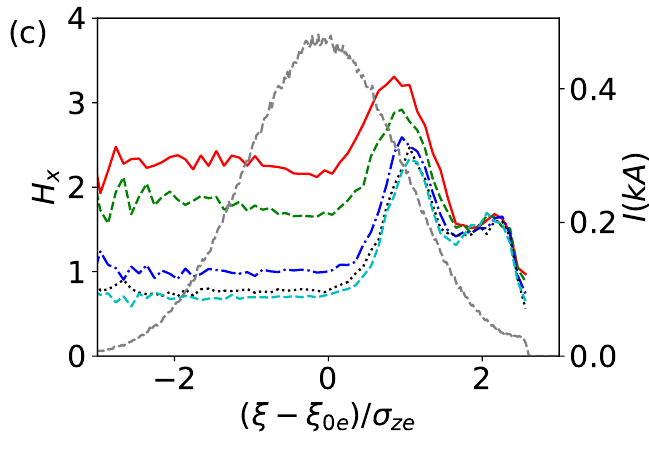
Figure 6. Halo parameters of witness beams with SG spatial profiles. Evolution of the transverse profile halo parameter H x for the ( a ) low-charge (120 pC) cases and ( b ) high-charge (400 pC) cases are presented. ( c ) The slice distribution of the high-charge beams’ halo parameter H x at the end of acceleration ( s = 10 m). Slice bin size is 5d z and d z = 0.01 k − 1 p is the longitudinal grid resolution. The longitudinal coordinates of beam slices are relative to the initial centroid position ξ 0 e and normalized by the initial witness bunch length σ ze . The absolute current profile I is shown by the grey dashed